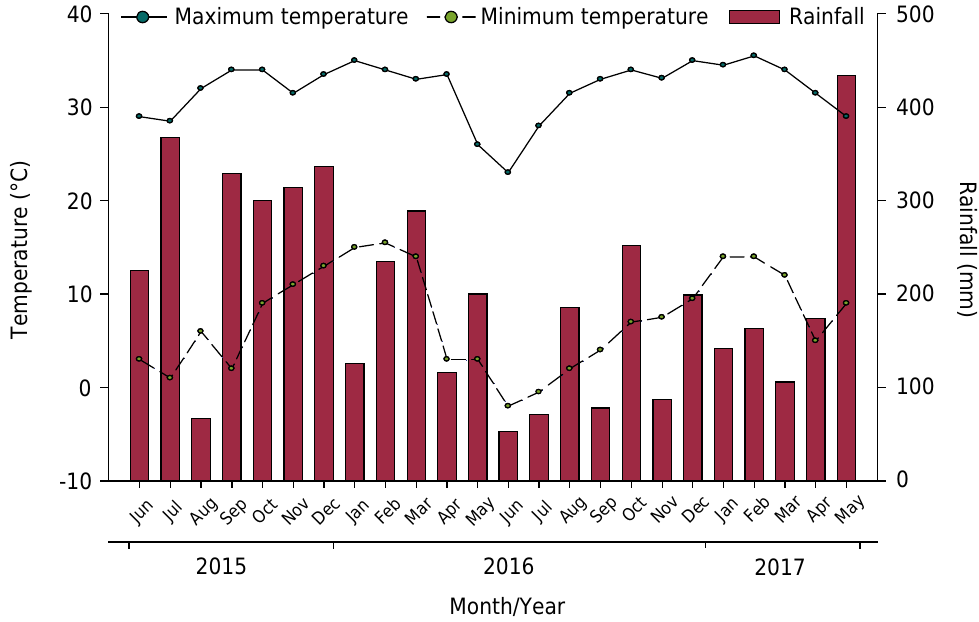
Figure 1. Rainfall and maximum and minimum temperatures registered during the experiment in the 2015-2017 crop seasons, Concórdia, Santa Catarina,